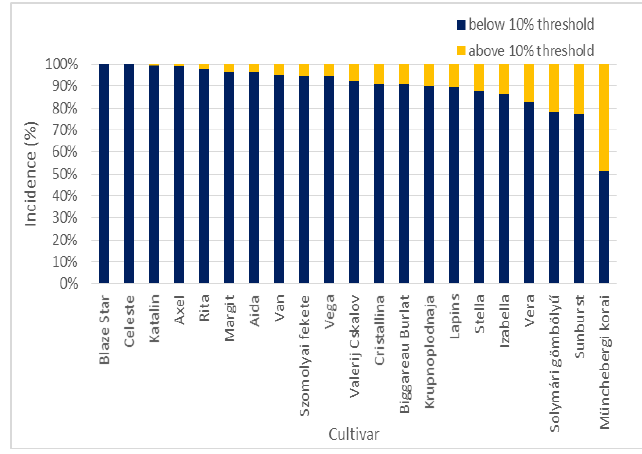
Figure 3. Classification of 21 sweet cherry cultivars for the spacing of 4 x 1 m according to the 10% disease threshold level for chery leaf spot (distributions of above and under 10% disease